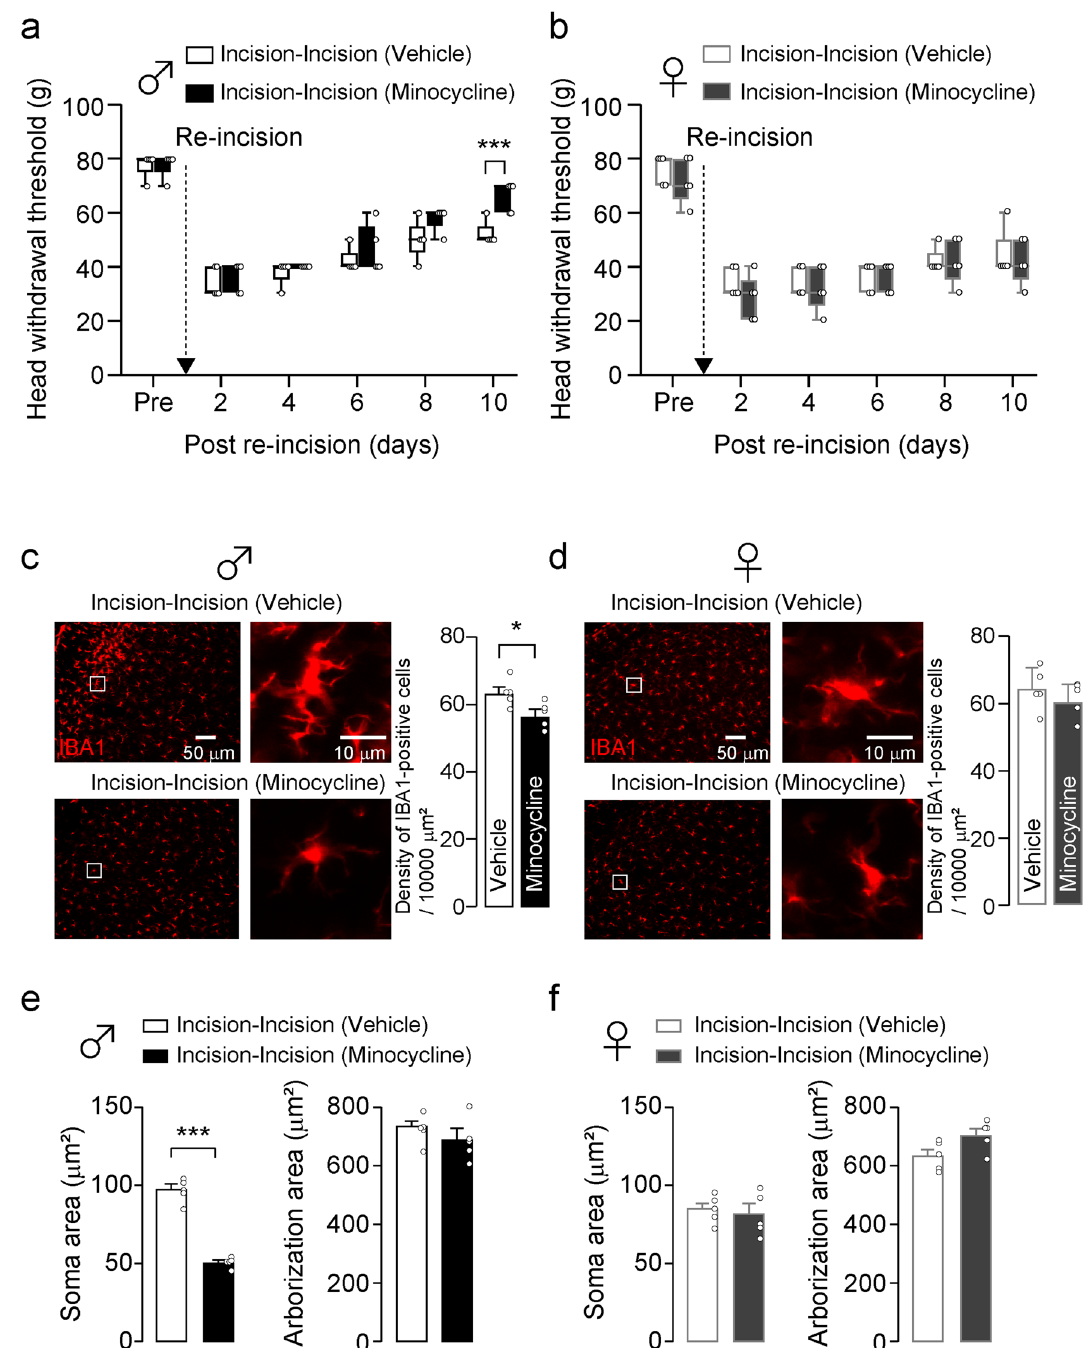
Figure 2. The effects of minocycline on incision-induced prolonged HWT decline and the number of Vc microglia of both male and female rats. ( a, b ) Time course of HWT of male rats ( a ) and female rats ( b ) after whisker pad skin re-incision. Vehicle or minocycline were continuously delivered in the cisterna magna by an osmotic pump before whisker pad skin re-incision. Broken arrows indicate that the whisker pad underwent skin re-incision at 7 weeks of age. “Pre” indicate the day before skin incision. Boxes show the 25th–75th percentiles with the median value indicated as a line within each box. Whiskers indicate the 10th and 90th percentiles of the data. n = 5 rats in each, GEE method post hoc Bonferroni’s test (*** p < 0.001, Vehicle vs. Minocycline) ( c, d ) The representative images of IBA1 immunofluorescence in the Vc. The right images are enlarged images of insets in the left images. Scale bars = 50 µm (left images) and 10 µm (right images). The columns represent the mean number of IBA1-positive cells in the Vc 10 days after whisker pad skin re-incision. Data represent the mean ± SEM. n = 5 in each, unpaired t-test, * p = 0.0269 in ( c ). ( e, f ) Soma area and arborization area of Vc microglia in male ( e ) and female rats ( f ). The columns represent the mean soma area and arborization area of microglia in the Vc 10 days after skin re-incision. Data represent the mean ± SEM. n = 5 in each, unpaired t-test, ** p < 0.001 in ( e